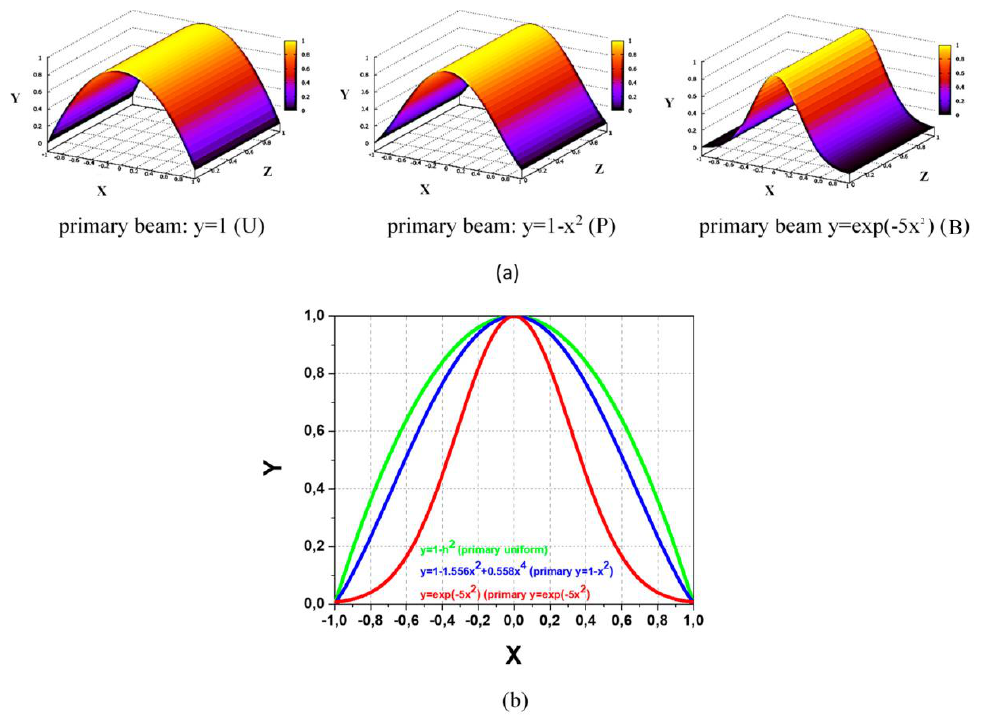
Figure 4. Normalized 3D images ( a ) and 2D profiles ( b ) of the secondary beam obtained by integration in planes of primary beam chord slices for uniform ( y = 1), parabolic ( y = 1 − x 2 ) and bell-shape ( y = exp( − 5 x 2 )) primary